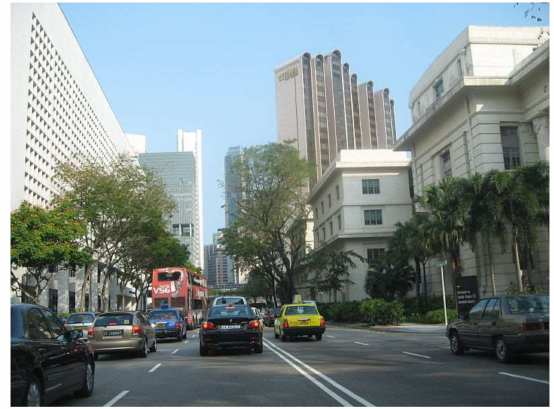
Figure 3. Modern-day Havelock Rd (Terence Ong, https: // commons.wikimedia.org / wiki / File:Havelock